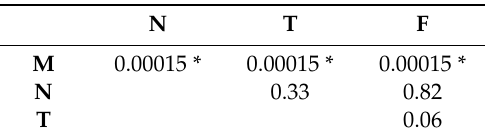
Table 2. p -values were obtained in a post-hock Tukey test for individual selection time given to di ff erent selection confirmation methods (* p < 0.05). See the caption of Figure 1 for the description of the confirmation